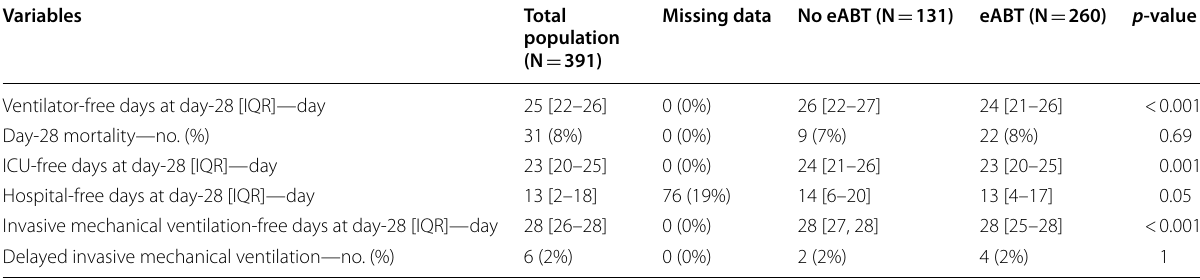
Ventilator-free days were defined as number of days without any respiratory assistance, invasive or non-invasive (or return of premorbid ventilation parameters in case of chronically ventilated patients). If the patient died at any time between admission and day-28, VFD were set to 0. ICU-free days and invasive